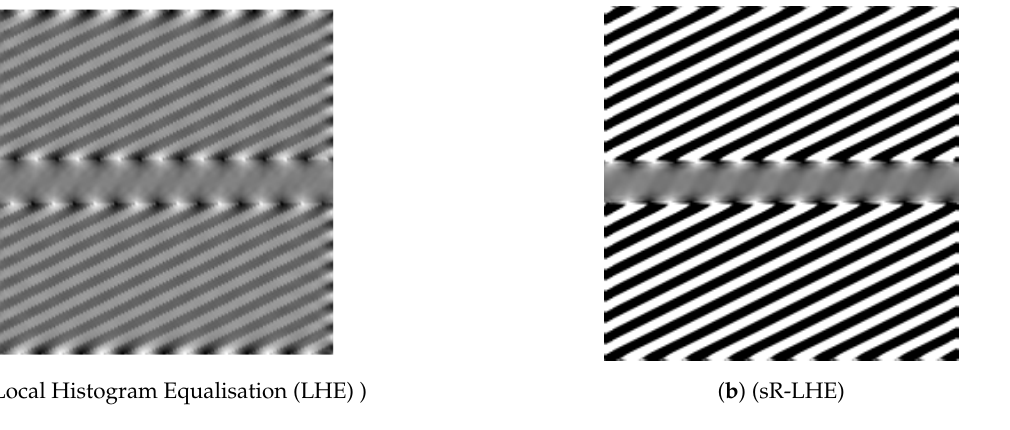
Figure 5. Model output for Poggendorff gratings in Figure 3b via LHE models. ( a ) result of the LHE model proposed in [44,45]. ( b ) result of (sR-LHE) with parameters α = 8, τ = 5, λ = 2, σ µ = 1, ∆ t = 0.15, ∆ τ =